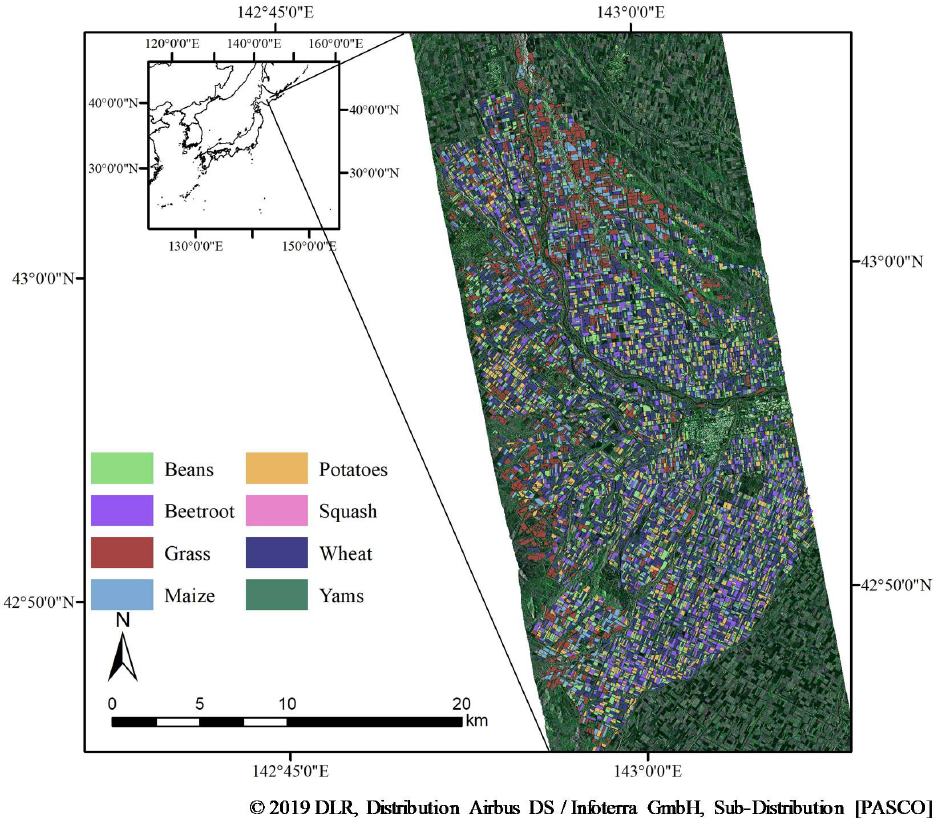
Figure 1. Study area and TerraSAR-X data acquired on July 20, 2013 (Red: odd-bounce, Green: randomly oriented, Blue: double-bounce scattering components calculated from m-chi